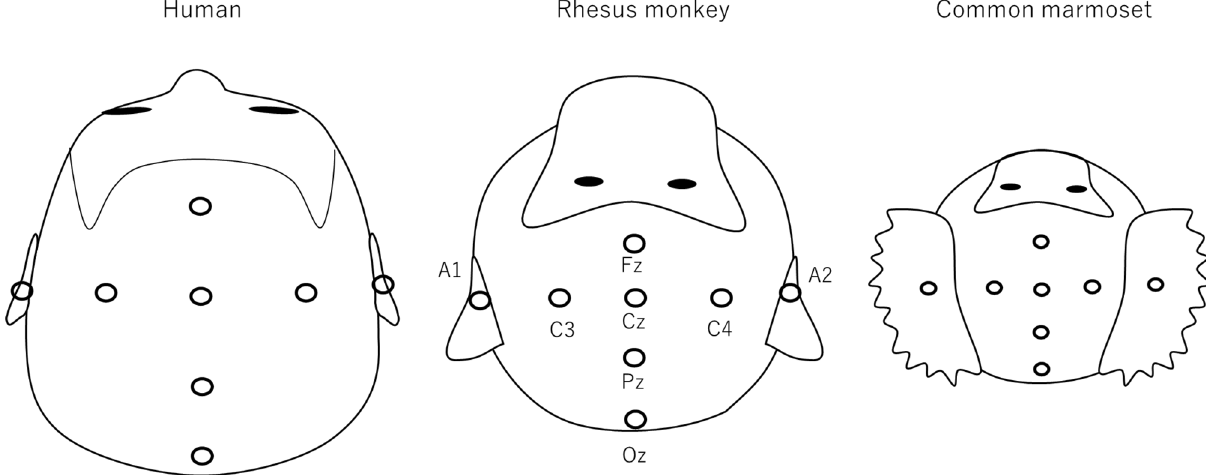
Figure 1. Location of electrodes in humans (left), rhesus monkeys (middle), and common marmosets (right). According to the International 10–20 system, the electrodes were placed with Fz, Cz, Pz, Oz, A1, and A2 in the same locations across all subjects, regardless of the species. The ground electrode was set at C3 or